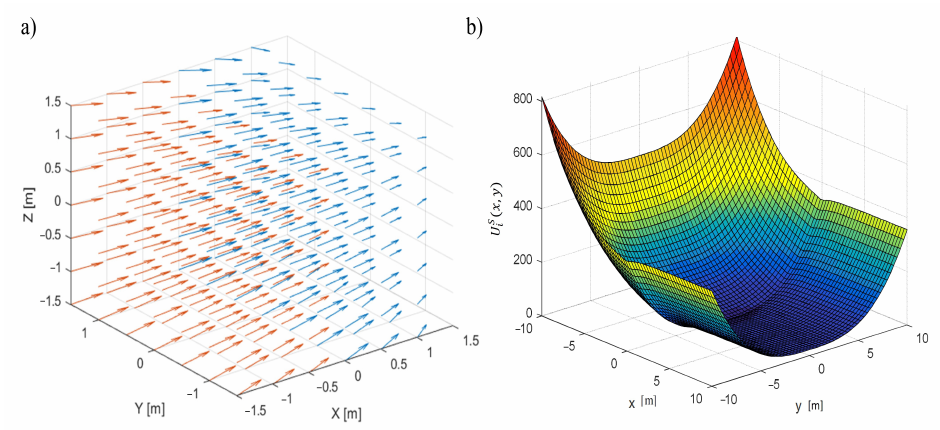
( x , y , z ) , the zone indicated with a red vector is the zone of i